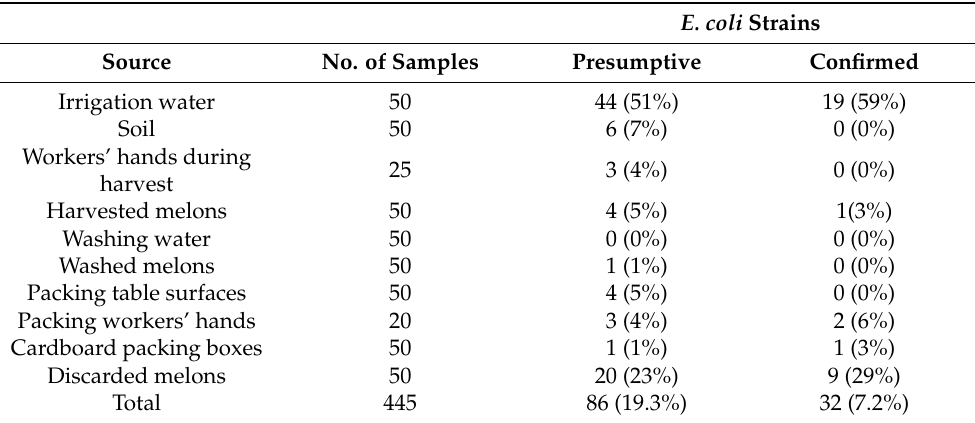
Table 1. Presumptive and confirmed E. coli strains isolated from the Honeydew melon farm and packing